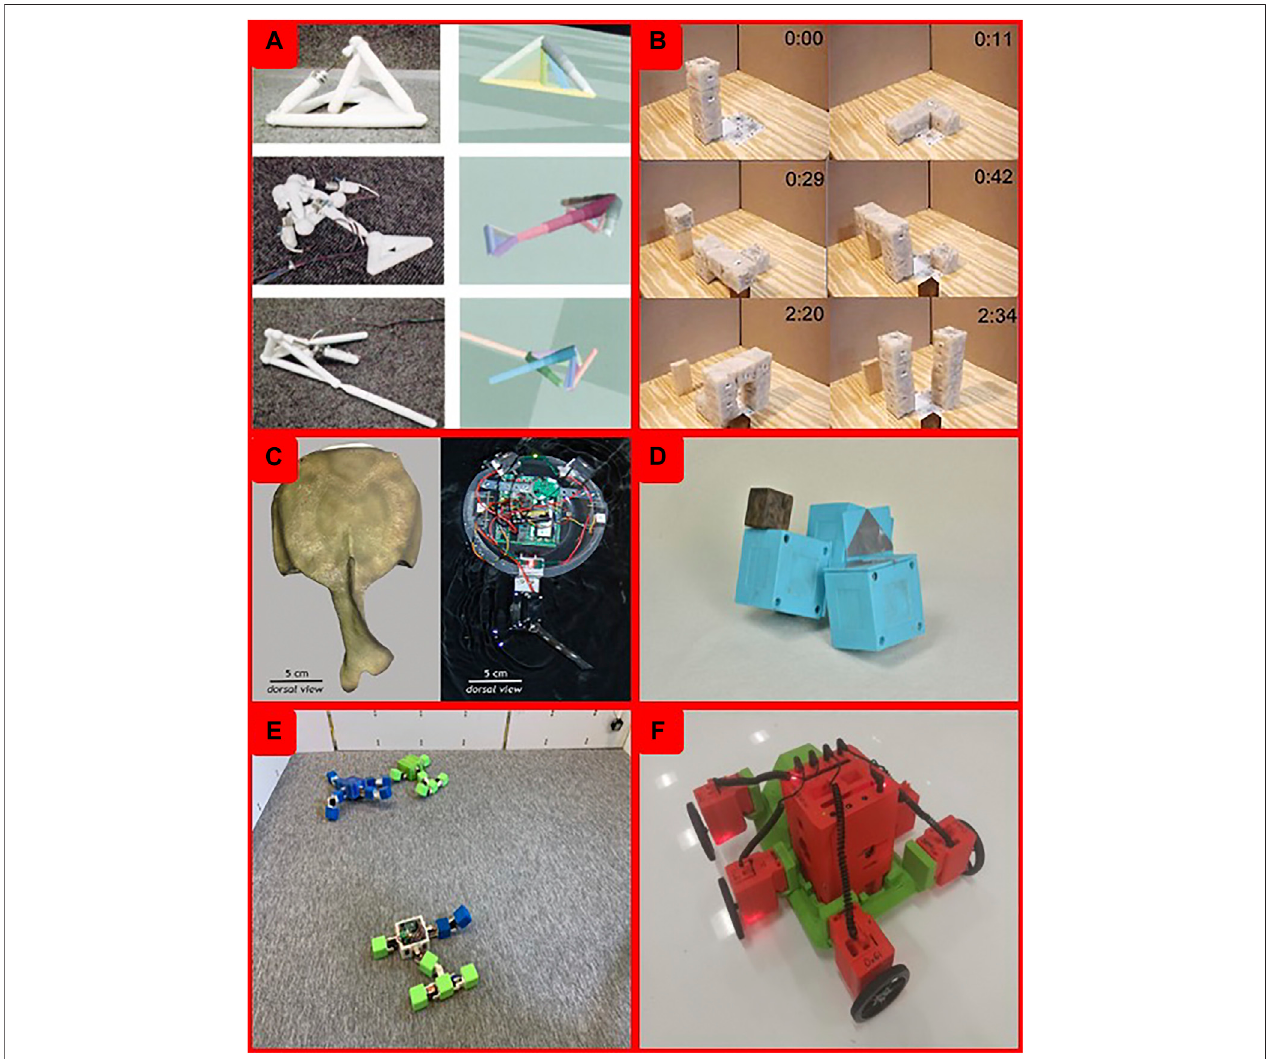
FIGURE 1 | Some of the landmarks of the history of robot evolution. We show examples of systems that demonstrated robot reproduction or evolution incarnated in the real world. (A) 2000: The GOLEM project (10) co-evolved robot bodies and controllers in simulation and fabricated the evolved robot afterwards. (B) 2005: A physicalsystembasedonMolecubes,demonstratednon-adaptiverobotsabletoconstructareplicaofthemselves( 12 ). (C) 2012:Tadrorobots( 13 )wereusedtoverifya hypothesis about the evolution of Cambrian vertebrates. Consecutive generations were constructed and evaluated in real hardware. (D) 2015: Semi-automated construction of genetically encoded modular robots (15). Consecutive generations were constructed and evaluated in real hardware. (E) 2016: The Robot Baby Project ( 17 )demonstratedthereproductionofgeneticallyencodedrobots.Robotsco-existedinthesameenvironment;theoffspringwasaddedthereafter “ birth. ” (F) 2019:The Autonomous Robot Evolution Project ( 18 ) features hands-free construction of genetically encoded robots. The robots have sensors and can co-exist in the same environment.Therobotsshownin (1A,C – E) hadnosensors.Therobotsshownin (1C,D) wereconstructedandevaluatedonebyone;thephysicalpopulationconsisted of one single robot at any time. The robots in (1B) are actually not evolvable, as there was no genetic encoding and the replica was an identical copy.